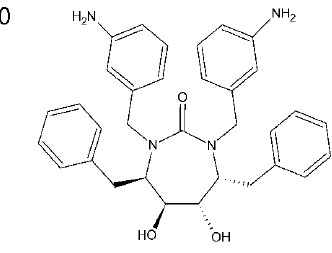
Figure 6. Chemical structure of DMP450 ( Mozenavir (DuPont)